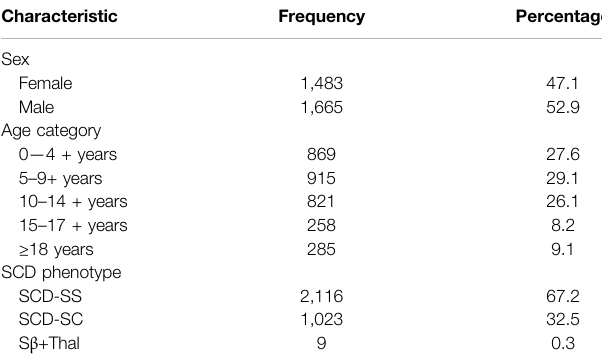
TABLE 2 | Demographic characteristics of